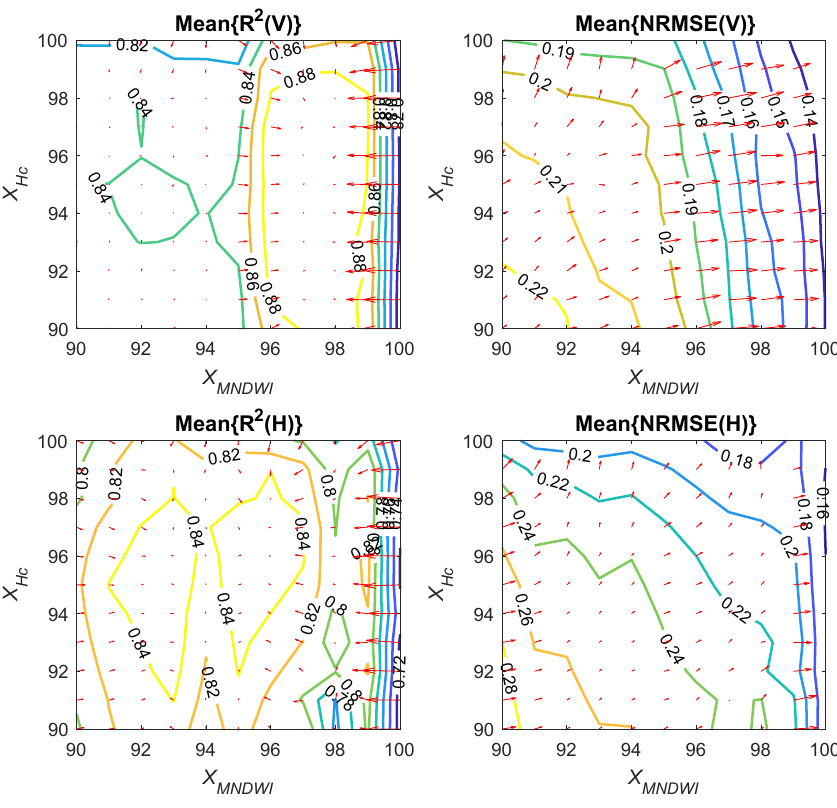
Figure 12. Sensitivity analysis of the two thresholds used to improve water body surface area estimates. Indices are averaged for all Jordanian reservoirs (except King Talal). Arrows point towards larger R 2 , or lower NRMSE, and lengths are proportional to the